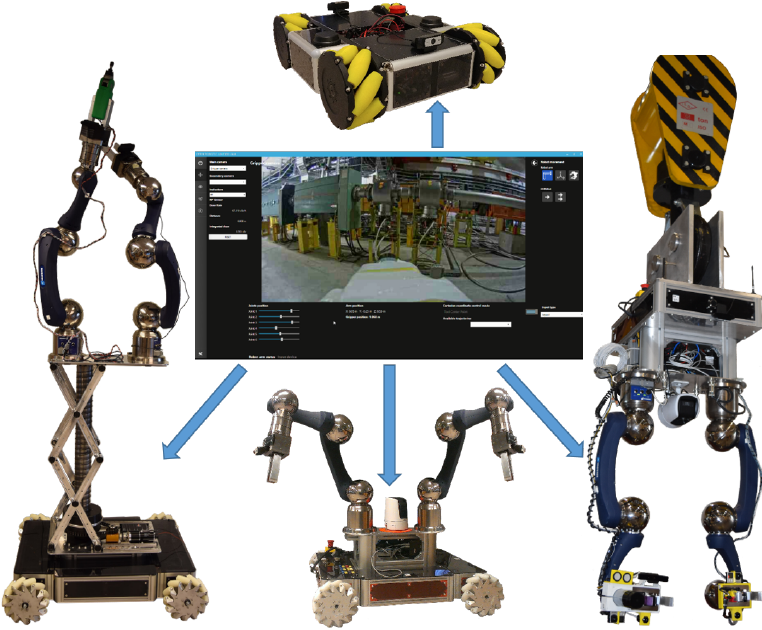
Figure 1. Unified multimodal human–robot interaction (HRI) to control the modular and reconfigurable CERNBot robotic